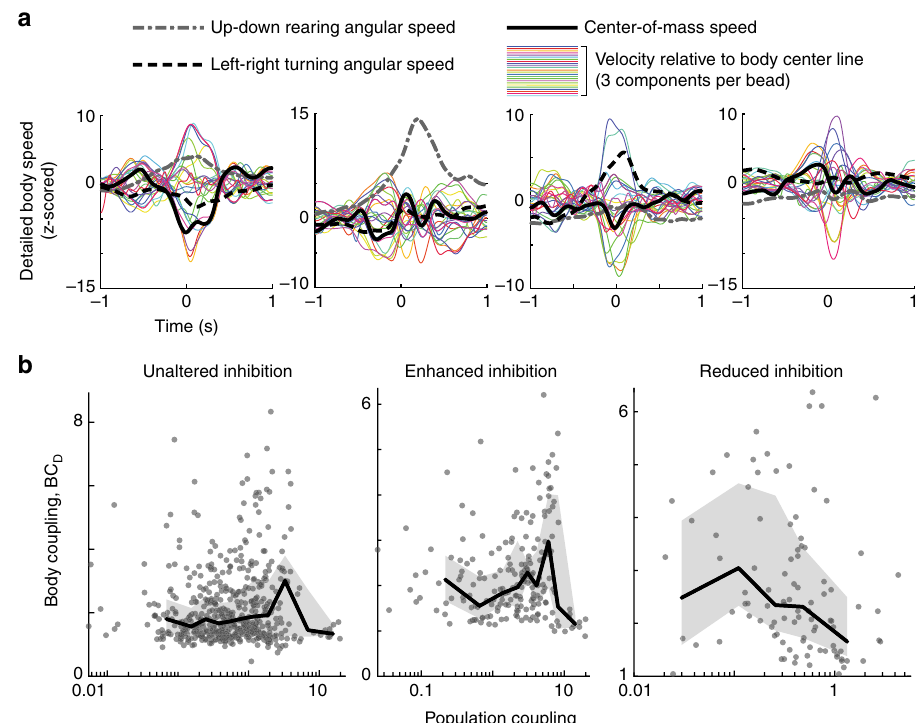
Fig. 7 Results hold for detailed body movements. a Each line shows a spike-triggered average waveform for one aspect of body movement including center- of-mass speed (black), left – right rotational speed (dashed), up – down body pitch angular speed (dash dot), and three orthogonal velocity components of each bead relative to the body center line (24 colored lines). Each trace is z -scored relative to 100 surrogate waveforms based on randomly time-shifted spike times. Different panels correspond to different units. Considering all 27 aspects of movement, BC D quanti fi es the “ bump ” size for the spike-triggered waveform with the largest “ bump ” for each unit. b Body coupling BC D , similar to BC S and BC M , peaks for intermediate population coupling. Each gray point represents one unit. Black line is a binned average of the points. Gray shaded area delineates